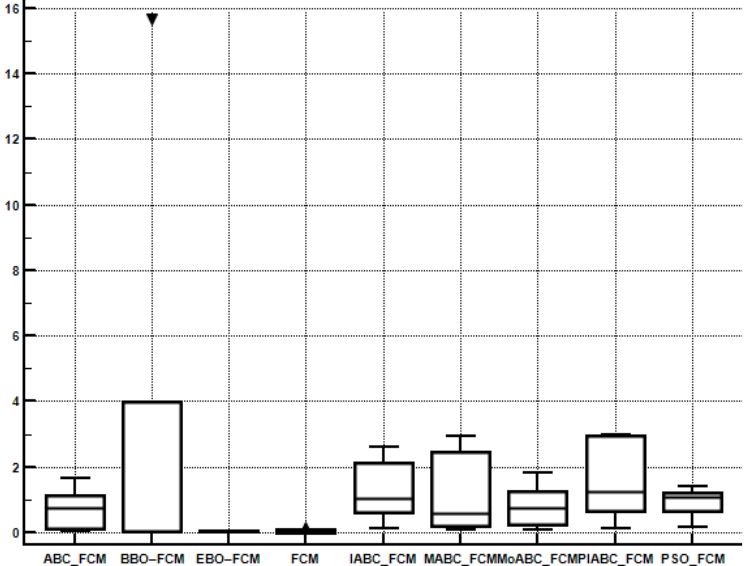
Figure 9. Box-whisker graph to present the outcomes of the S index.